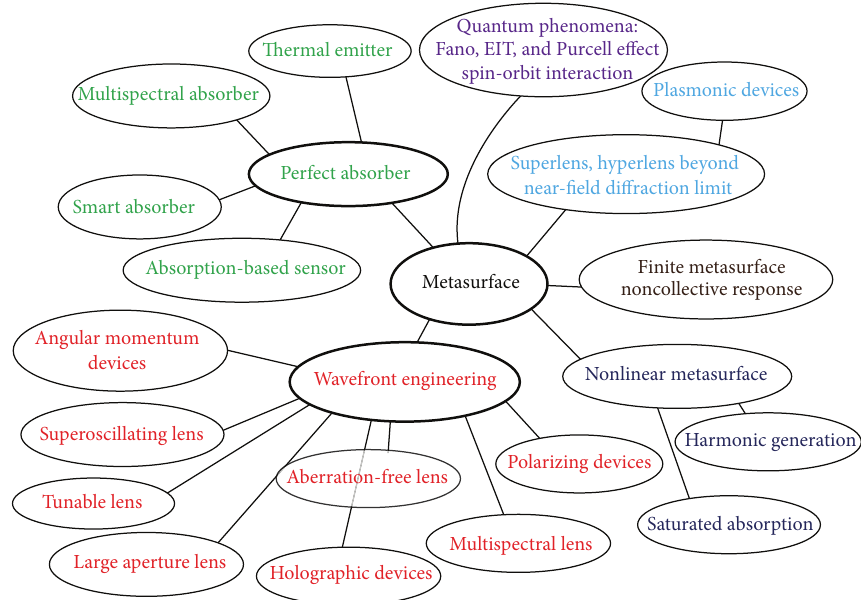
Figure 56: Outlook of the future trends of metasurface and metadevices. Figures are reproduced from